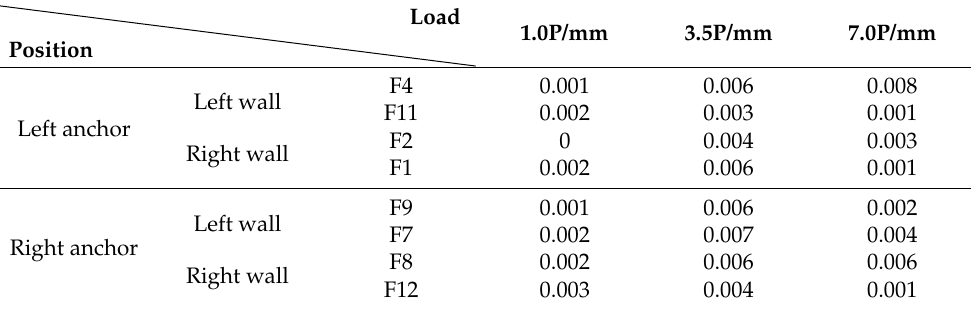
Table 2. Flow deformation of dislocation meter.